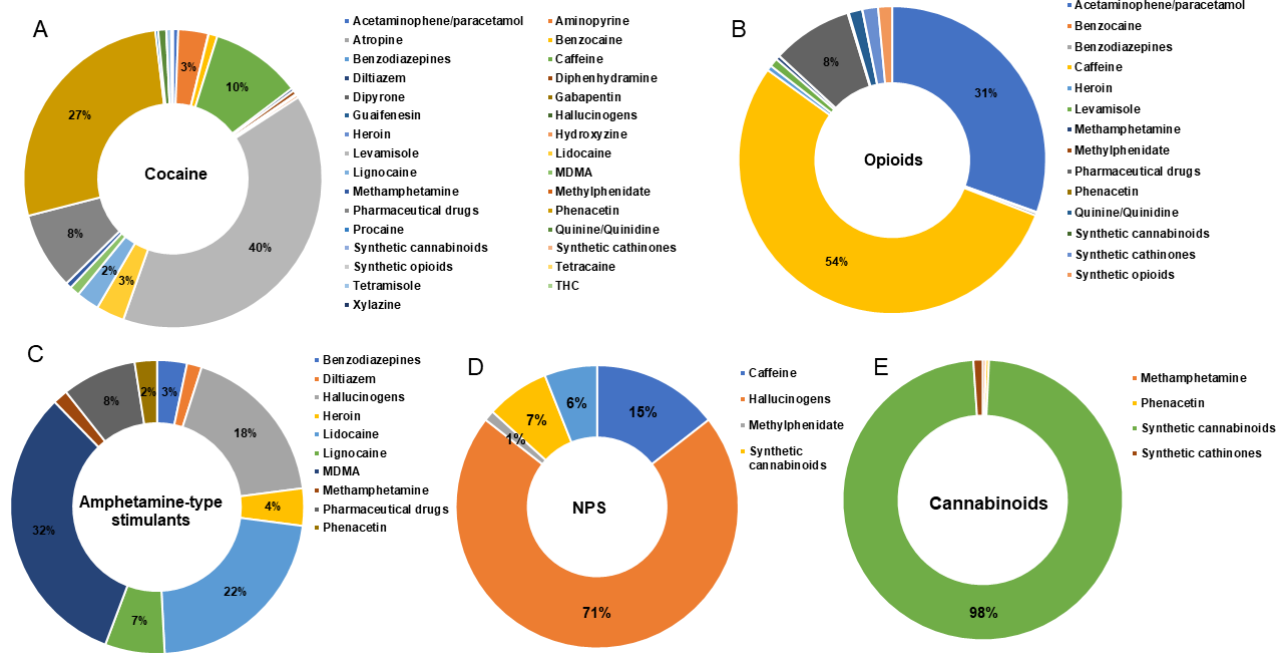
Figure 1. Adulterants prevalence in cocaine ( A ), opioids ( B ), amphetamine-type stimulants ( C ), new psychoactive substances (NPS, D ) and cannabinoids ( E ) seized samples.